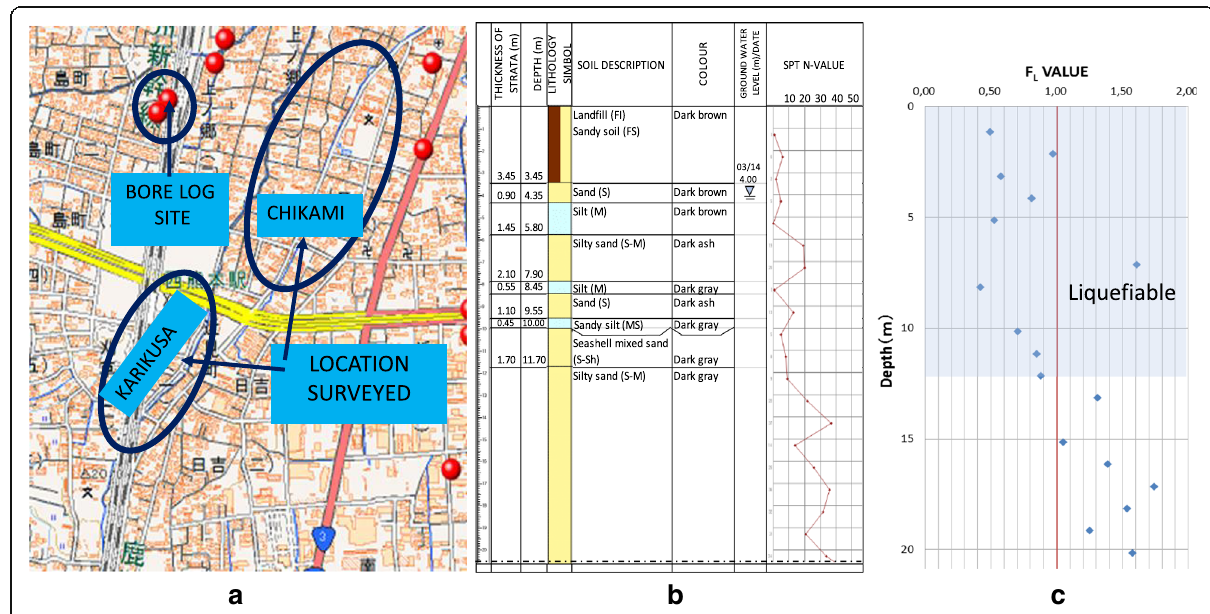
Fig. 15 a Bore log site in Chikami and Karikusa; b Borehole data obtained; c FL values calculation result for Chikami and Karikusa area